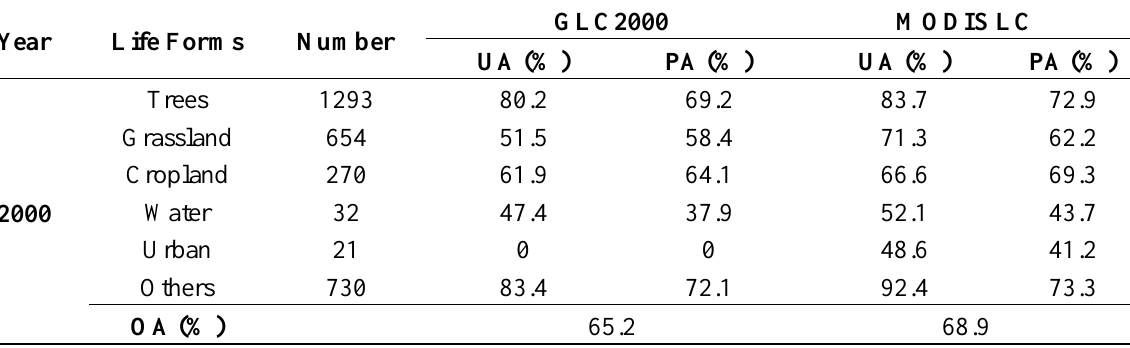
Table 3. Summary of error matrixes for GLC2000 (Global Land Cover 2000 project data), MODIS LC (Moderate Resolution Imaging Spectro-radiometer Land Cover product) in China.